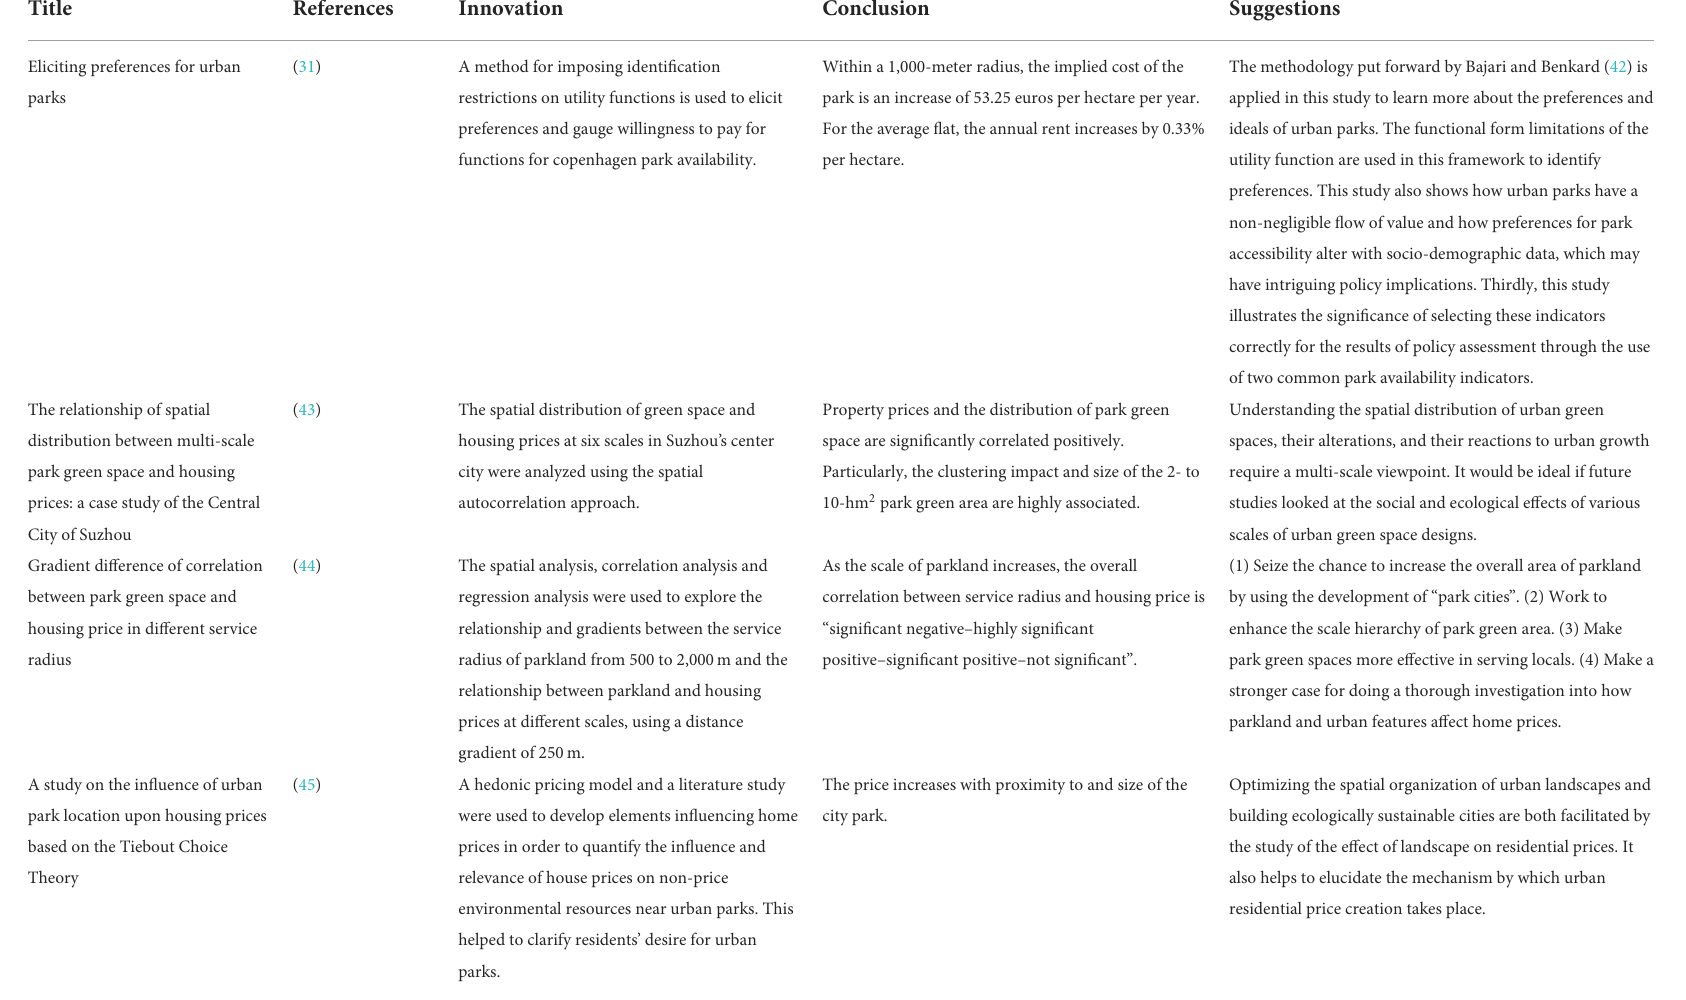
TABLE 6 Literature review of the impact of Parkland variability on housing